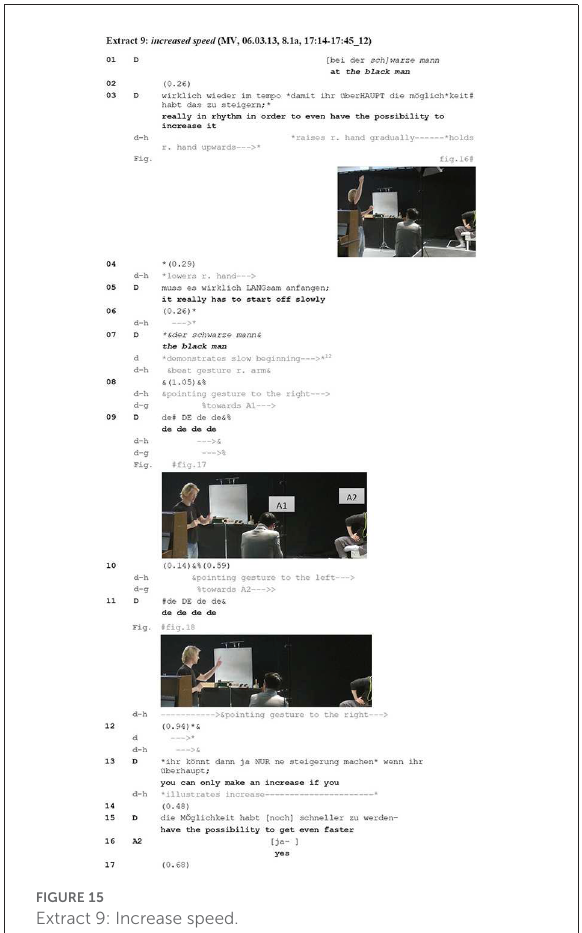
FIGURE15 Extract 9: Increase